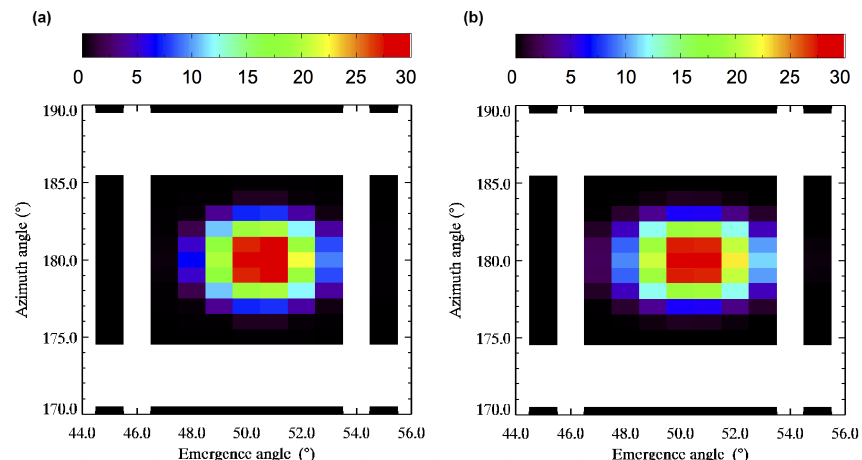
Figure 8. Measured and simulated reflectance factor around the specular geometry at 1 . 5µm for an incidence angle of 50 ◦ . The simulation was computed assuming the determined shift of 0 . 5 ◦ in emergence and 0 . 2 ◦ in azimuth.